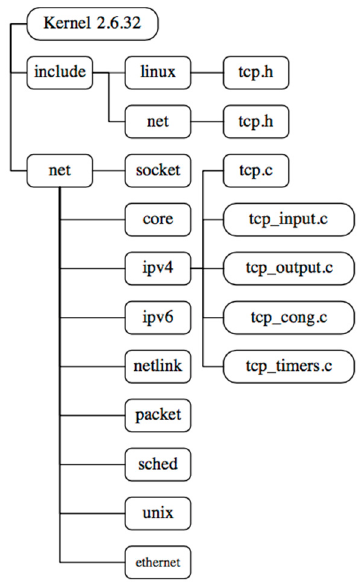
Figure 2. Linux source code architecture.